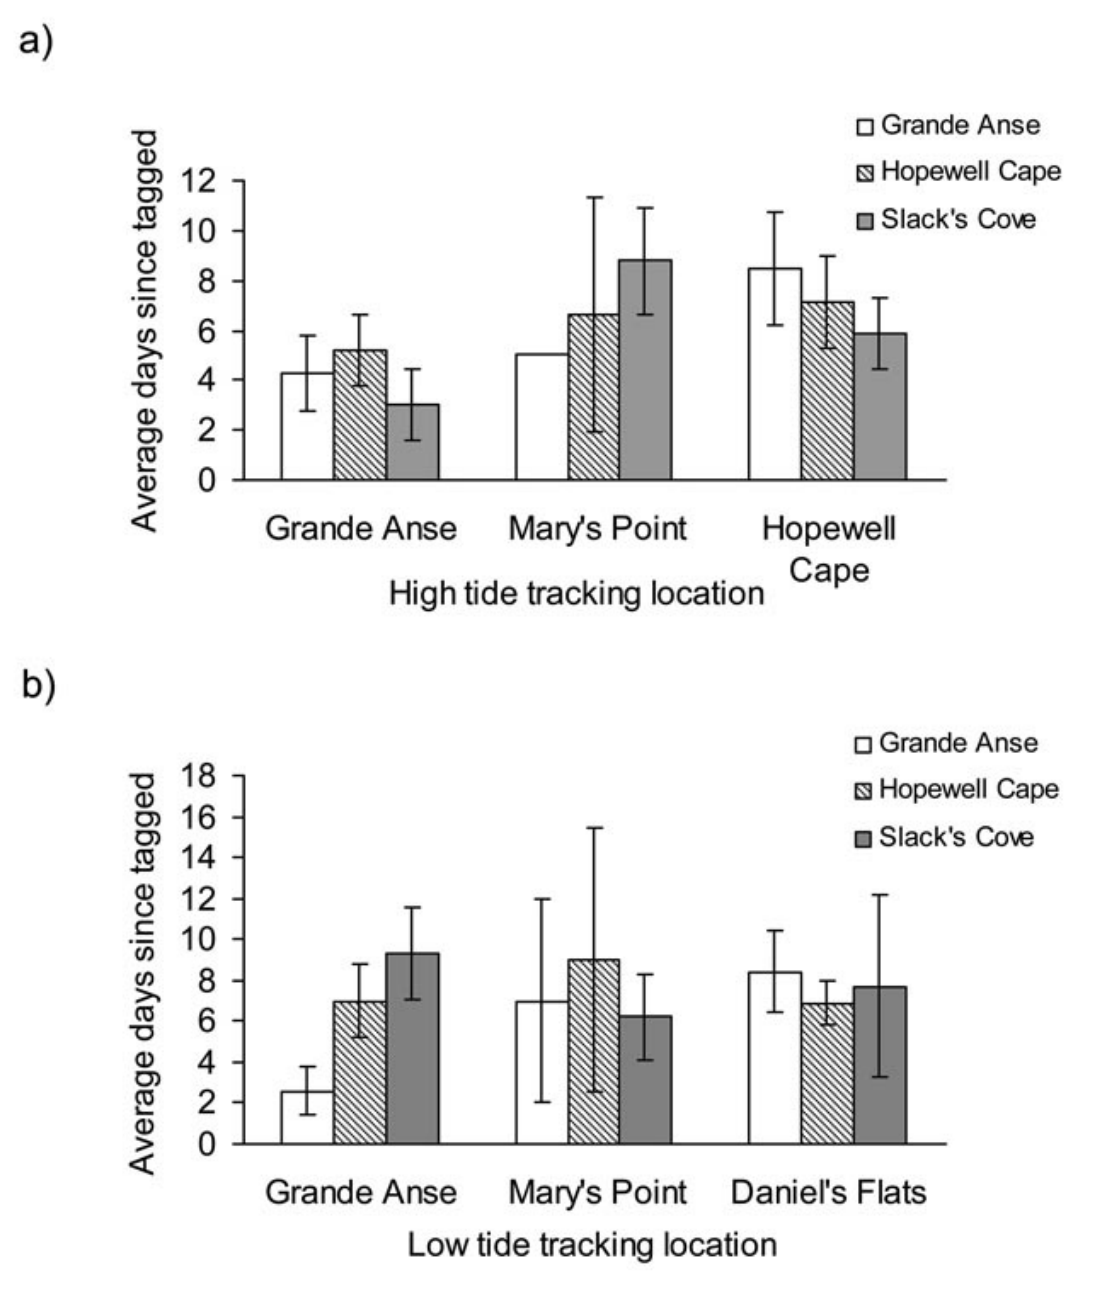
Fig. 7. Average number of days since being tagged that birds were located at each site in Shepody Bay 2005 for (a) high tide and (b) low tide. Separate bars represent birds tagged from the three capture sites, as indicated in the legend. Error bars are ± 1